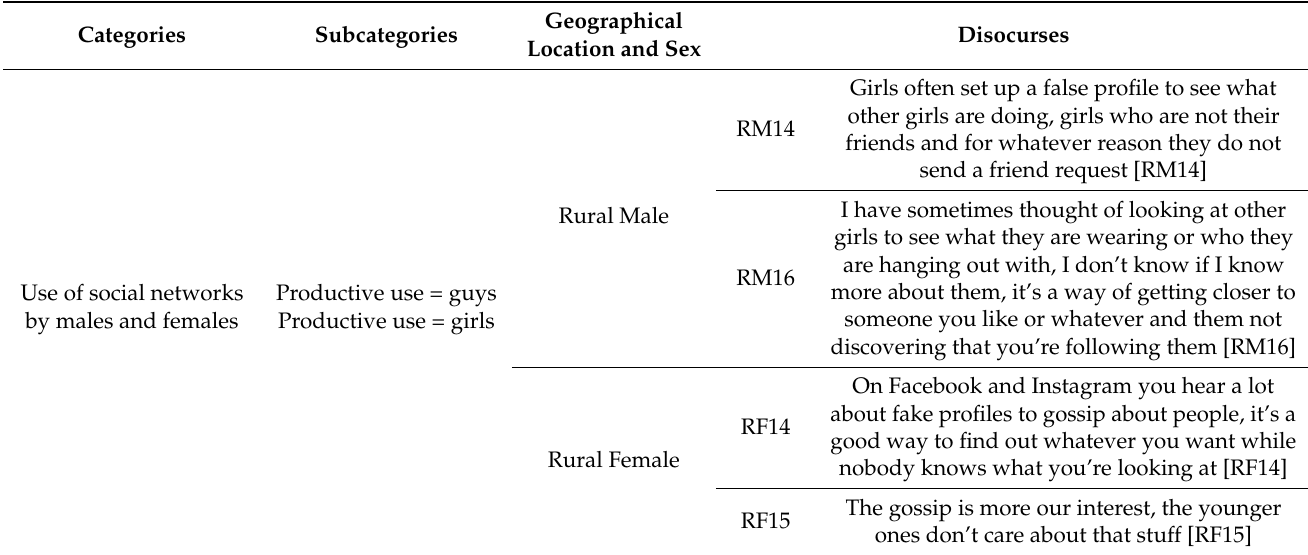
Table 4. Motives for using them and the way in which they are used girls and guys.